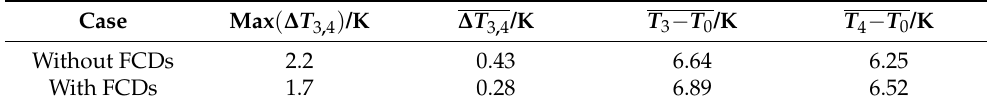
Table 5. Temperature measurement in non-isothermal